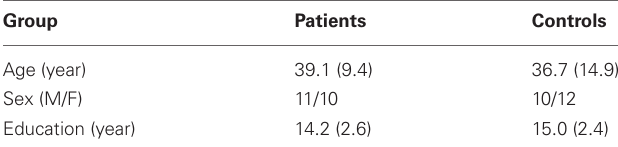
Table 1 | Demographic information of